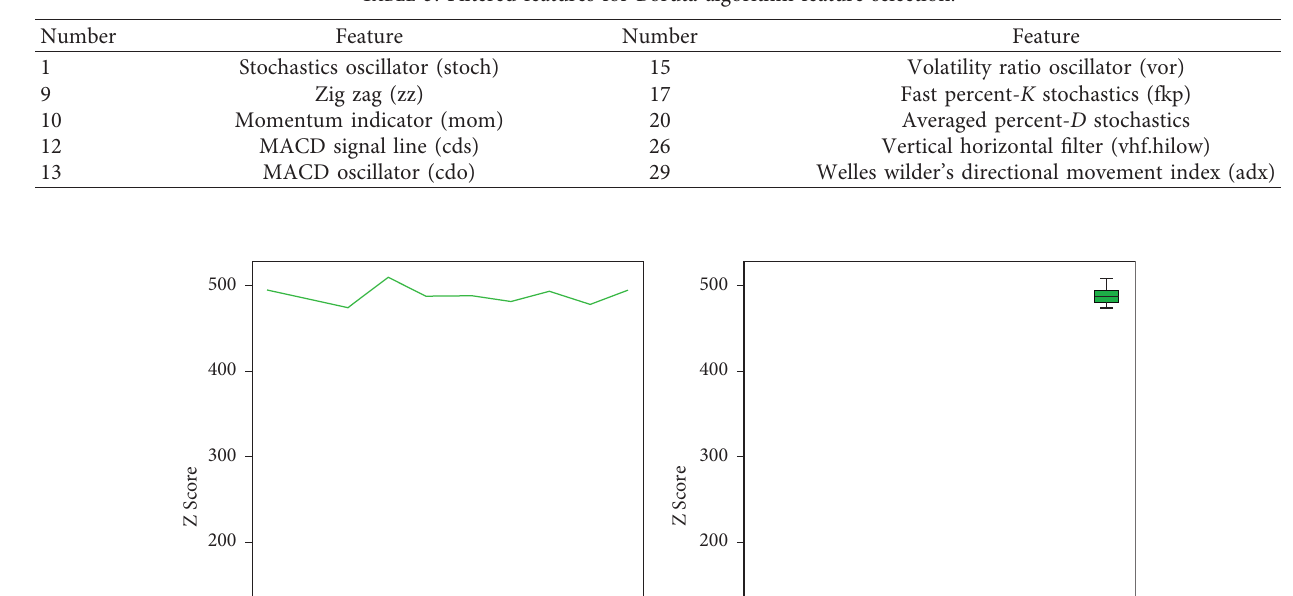
Figure 6: Correlation matrix after filter. (a) Visualization in numbers. (b) Visualization in circles. Table 5: Filtered features for Boruta algorithm feature selection.